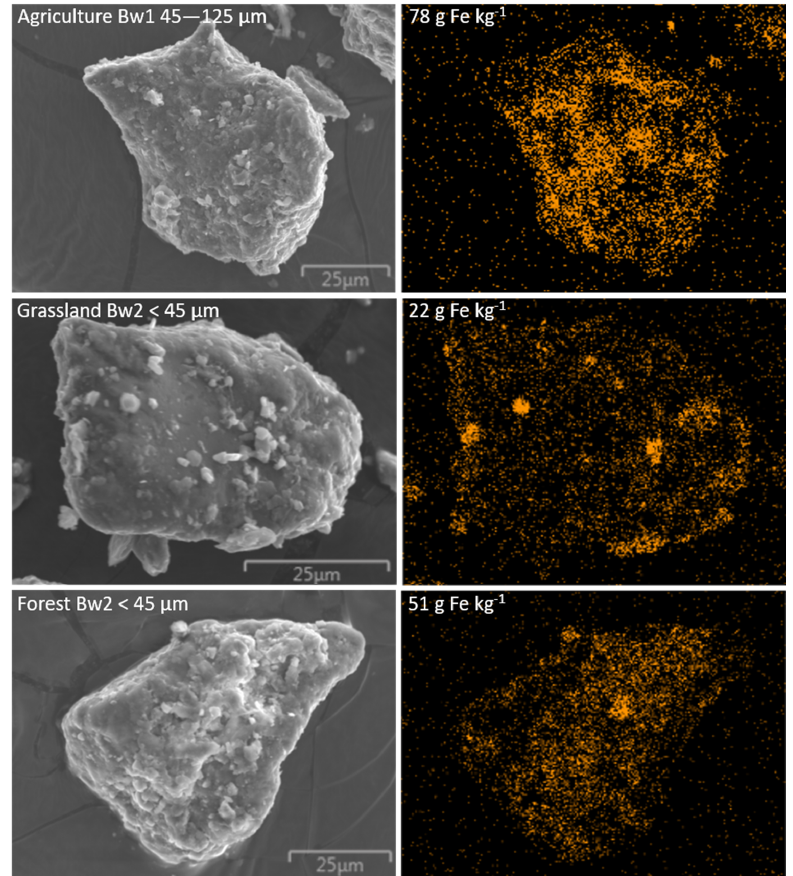
Figure 7. Iron coating of the surface of soil particles from the Bw soil horizons under different land use (SEM-EDS images and data).